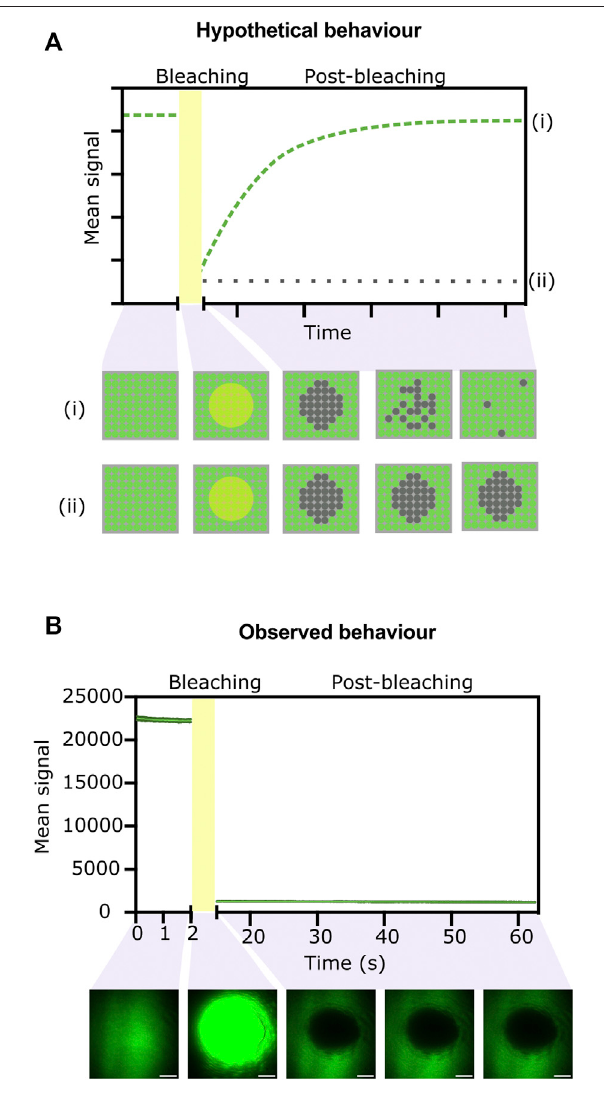
FIGURE 3 | FRAP experiments indicate that proteins do not move laterally in the BslA surface. (A) Hypothetical data showing the two extreme possibilities after a FRAP experiment. If the surface exhibits signi fi cant lateral mobility, the fl uorescence in a bleached area will be recovered over time as non-bleached molecules move in. The expected data from this scenario is indicated by the dashed green line (i) on the graph. The behaviour is illustrated in cartoon form in the panel below, which shows a top-down view of the proteinsonthesurface.Conversely,ifthe fl uorescentmoleculesdonotdiffuse laterally, fl uorescence will not be recovered after photobleaching (dotted grey lineon the graph, (ii) and matching cartoon). (B) Experimentally observed data for a BslA-SpT-SpC-GFP surface. No recovery of fl uorescence after photobleaching is observed, indicative of no lateral movement. Error bars show standard deviation, but theyare notclearly visiblebecausethevariability between replicates was very small ( n = 4). Representative images of the surface at different stages of the experiment are shown below the graph. Images have been colored green using Fiji. Scale bar represents 10